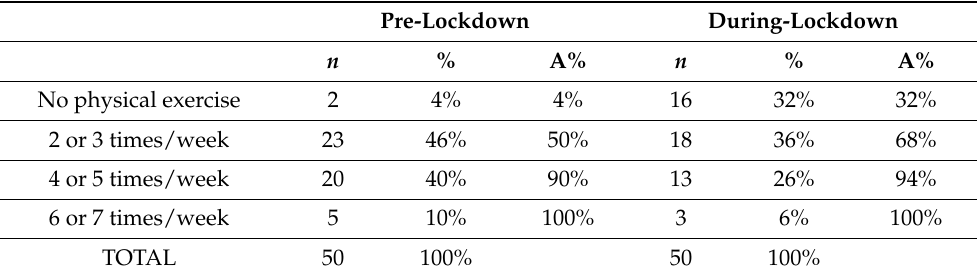
Table 6. Results of changes in physical activity habits pre-lockdown and during